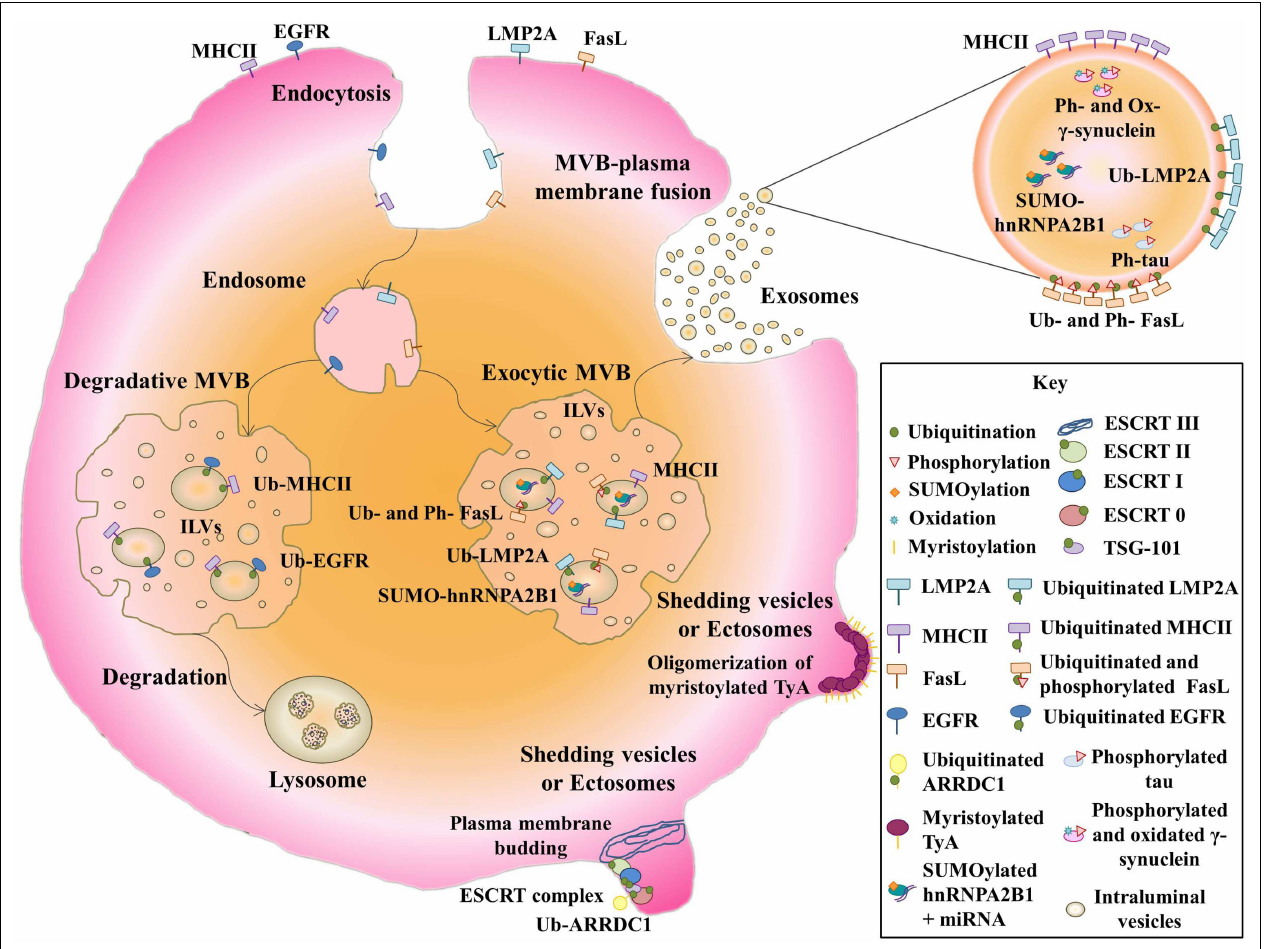
into exosomes. Non-membrane proteins like SUMOylated hnRNPA2B1, phosphorylated and oxidized γ -synuclein, and phosphorylated tau are packed into exosomes. MyristoylatedTyA protein is able to oligomerize, leading to the formation of shedding vesicles. Ubiquitinated ARRDC1 can induce plasma membrane budding by an ESCRT complex-depending mechanism, producing